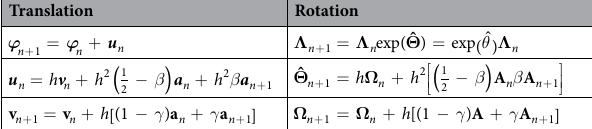
Table 1. Implicit time stepping algorithm.